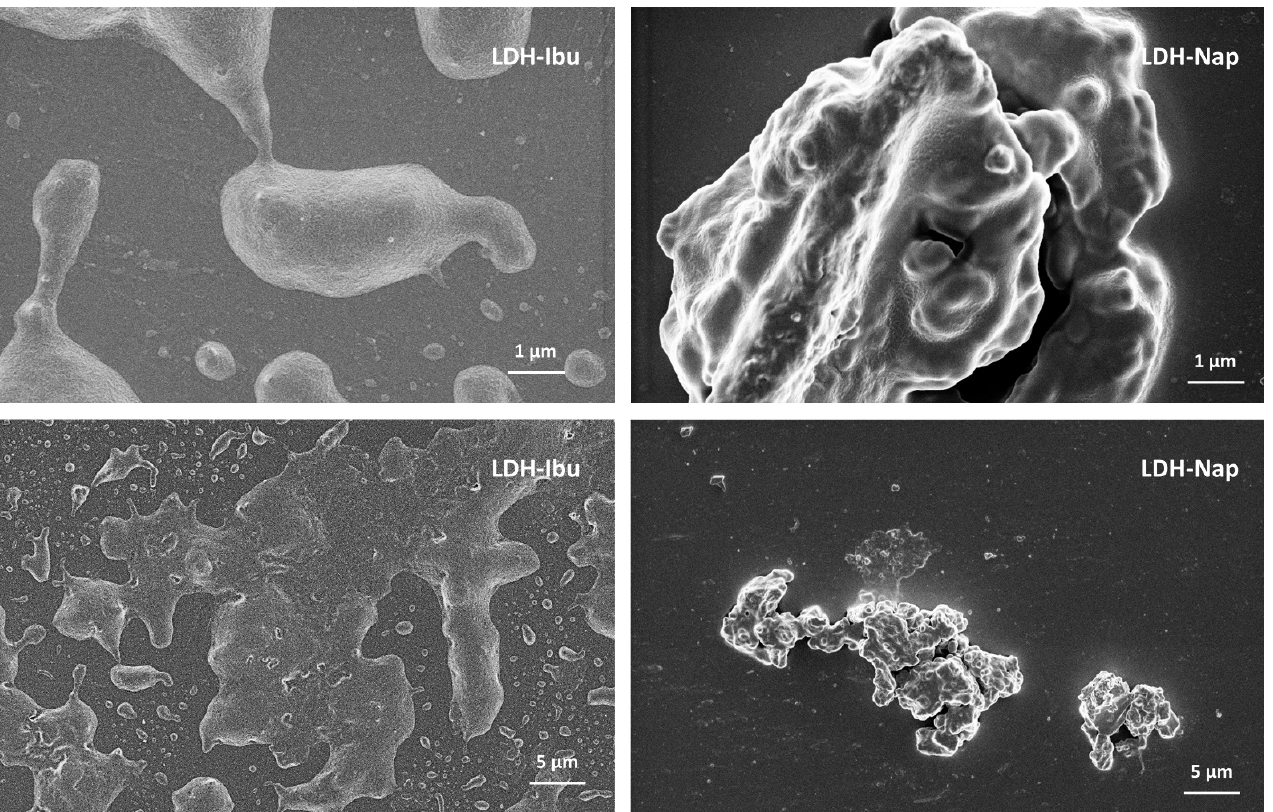
Figure 3. SEM images of LDH–drug samples shown at different